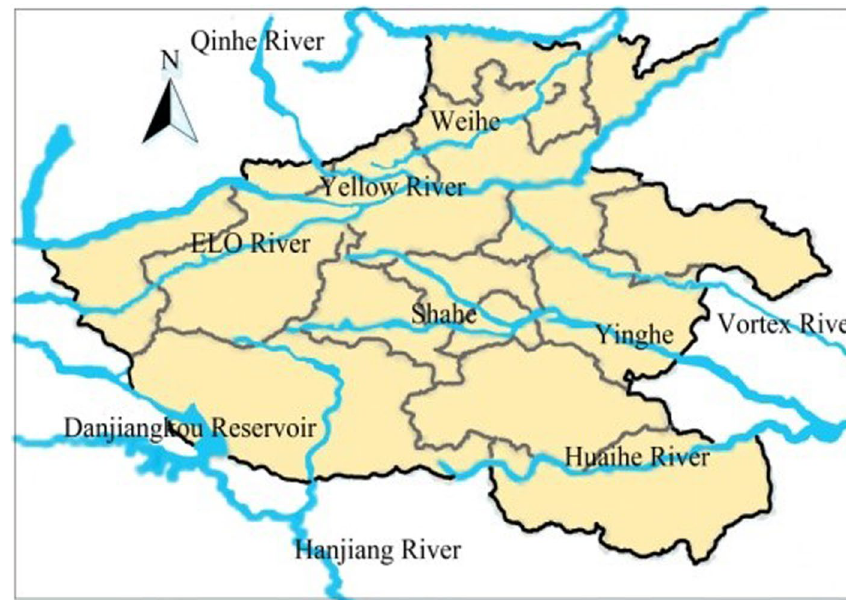
Fig. 2 Distribution of major